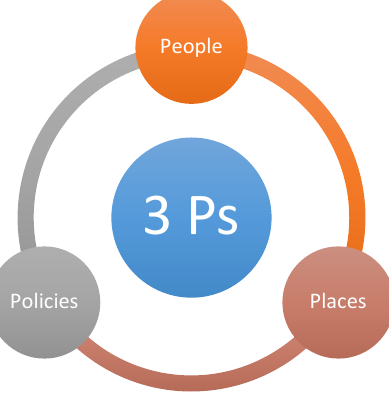
Figure 3. The “3Ps”Framework Source: OECD (2016), Water Governance in Cities. OECD Publishing, Paris.